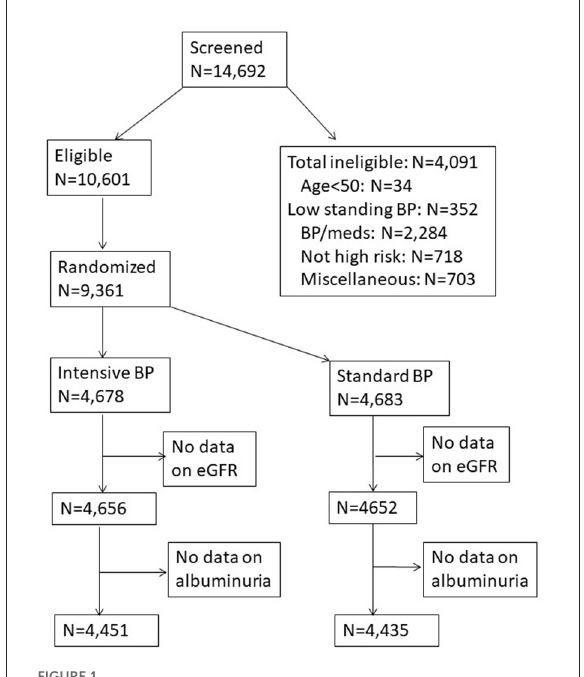
FIGURE1 Flow chart presenting selection of the SPRINT participants for the current